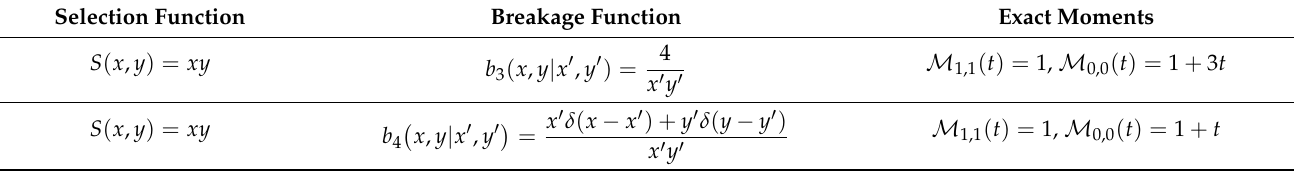
Table 9. Exact moment functions for S = xy and breakage functions b 3 , b 4 . Selection Function Breakage Function Exact